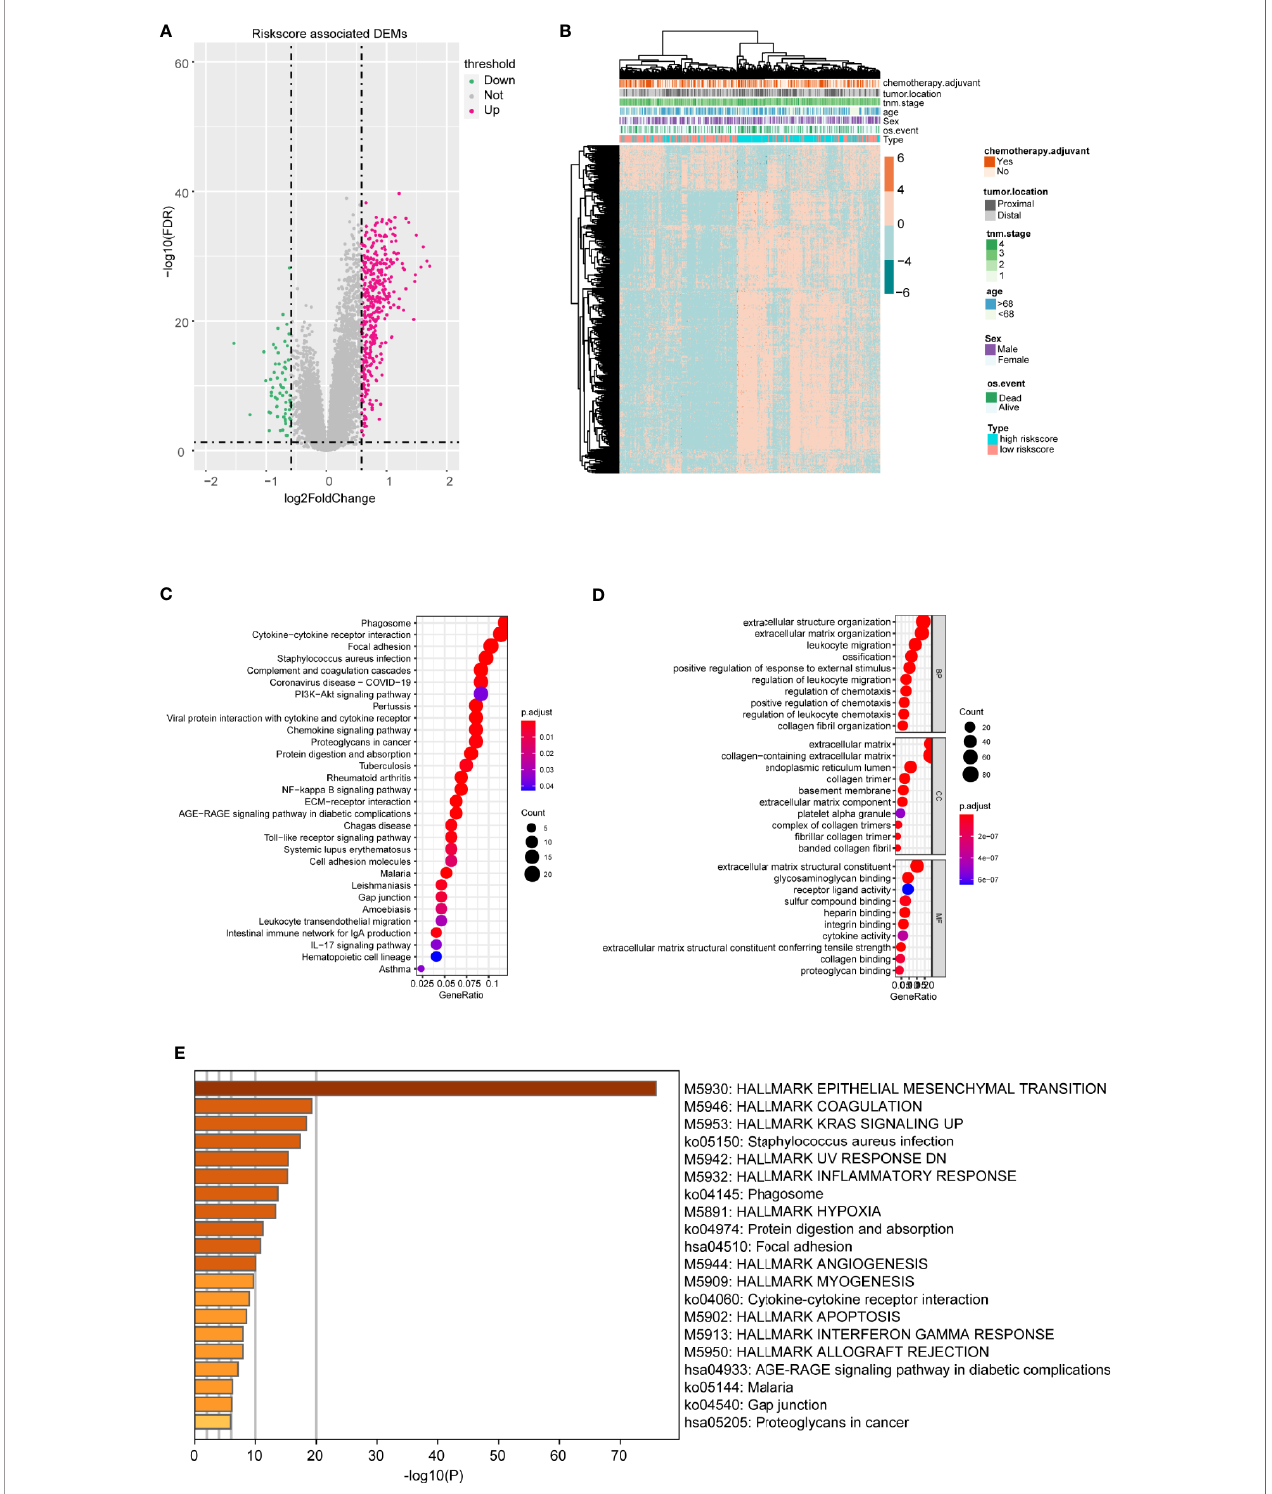
FIGURE 6 | Differential and enrichment analysis of DEGs between high- and low-risk m6A-TME-LM score subgroups. (A) Volcano plot showed the differentially expressed genes between the high- and low-risk score groups based on the m6A-TME-LM. (B) Heatmap is used for cluster the DEGs expression and clinical traits in CC. (C) KEGG enrichment analysis of DEGs. (D) Go terms enrichment analysis of DEGs. (E) Hallmark function enrichment analysis of